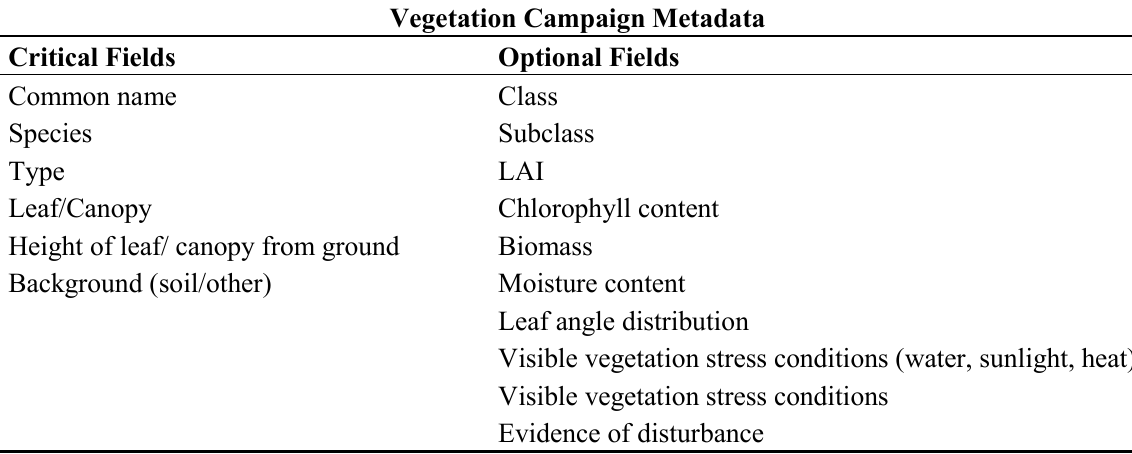
Table 5. Critical and optional fields in the ―Vegetation‖ metadata